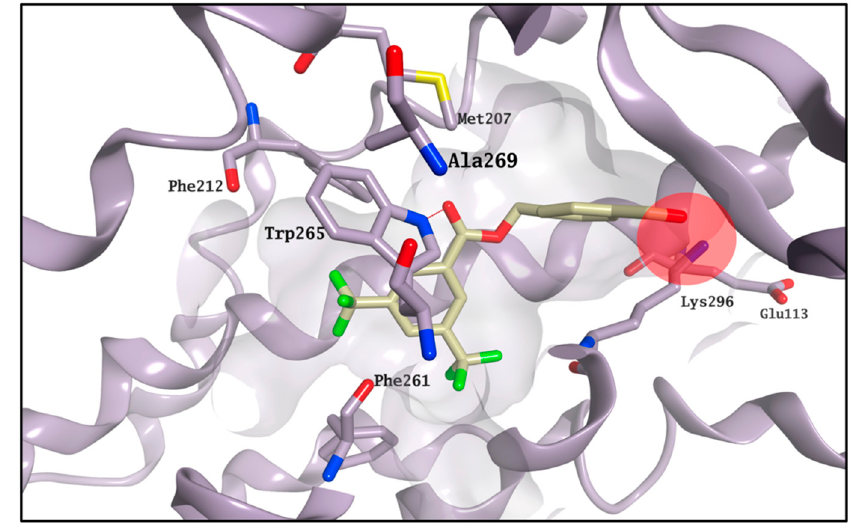
Figure 8. Binding mode for CF35Es (carbon atoms in light yellow) after MD simulation. The aldehyde moiety of CF35Es is placed nearby Lys296 during the entire simulation. The binding site area is represented as the molecular surface. Rhodopsin is represented as the lilac ribbon. Ribbon for residues 261–271 and 289–295 is hidden for clarity.